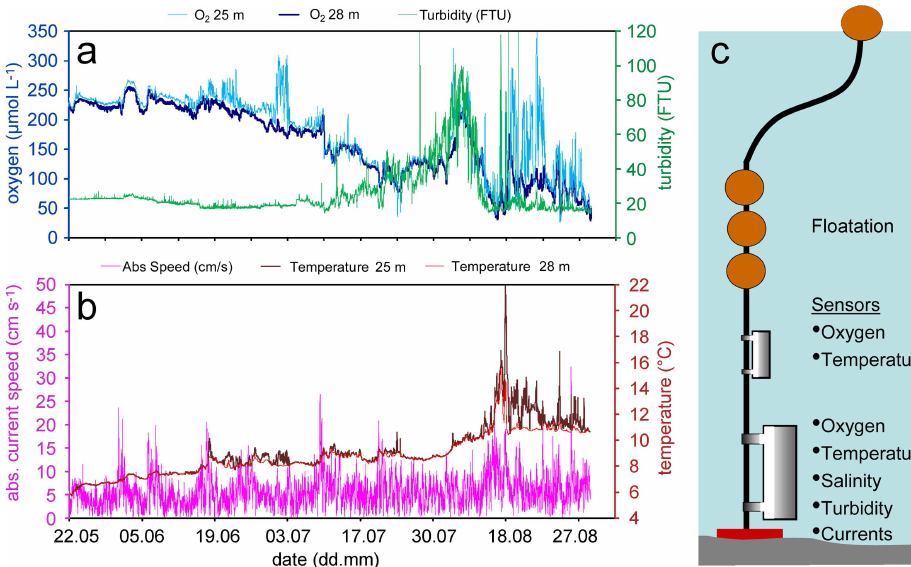
Fig. 6. Left-hand panel: time series of ( a ) oxygen concentration (µmolL − 1 ) and turbidity (Formazin Turbidity Units, FTU), and ( b ) tem- perature ( ◦ C) in 25 and 28m water depth and absolute current speed (cms − 1 ) above the seafloor. Data were collected from May to August 2010 on the Romanian Black Sea shelf (44 ◦ 34.681 0 N, 29 ◦ 14.620 0 E) with a recording current meter (Type RCM9, AADI, Bergen, Norway). Right-hand panel ( c ): schematic of the mooring.